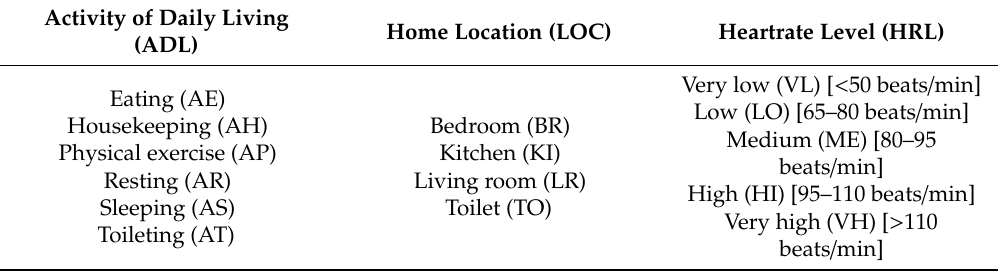
Table 2. Activities, home locations, and heartrate values used to generate the long-term